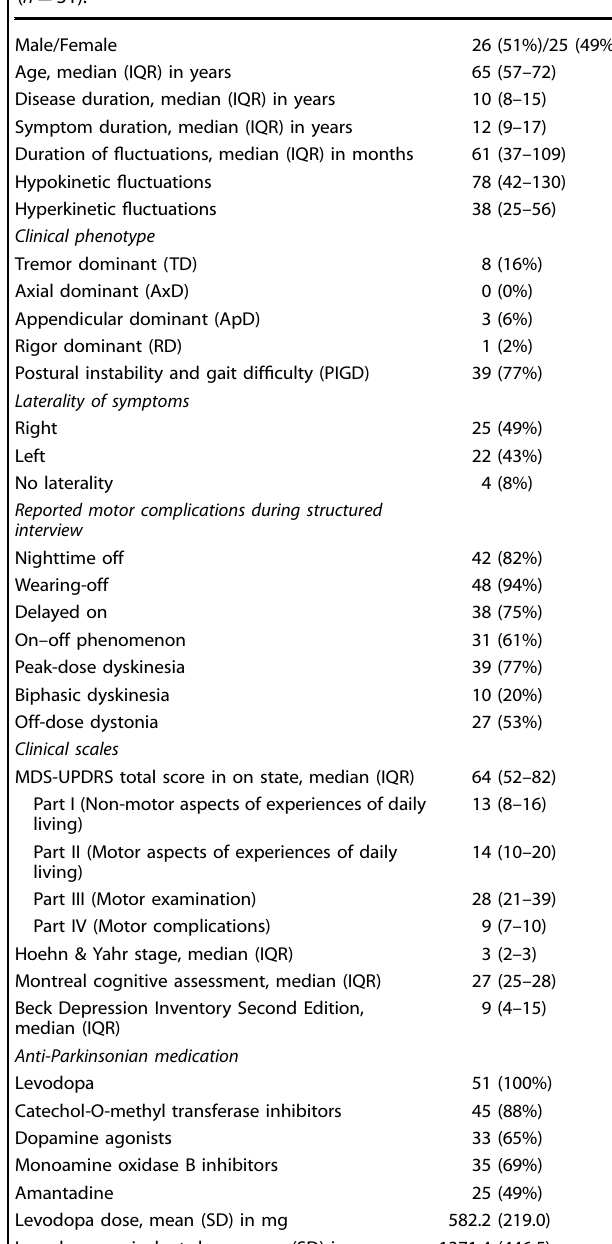
Table 1. Demographics and clinical characteristics of the study cohort ( n = 51).